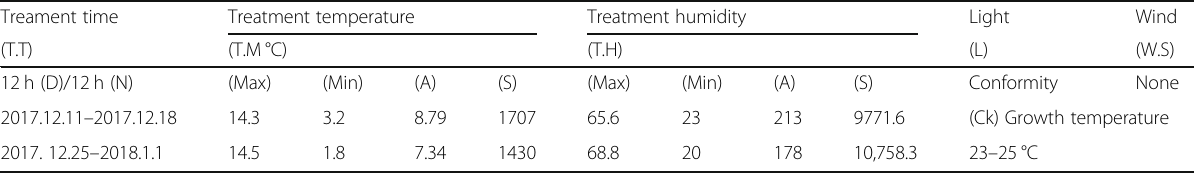
Table 4 The cold treatment and growth condtions for 133 rice varieties Treament time Treatment